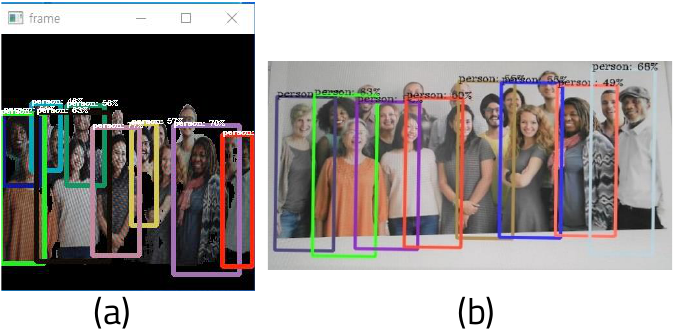
Figure 14. Result of detection of numerous people: ( a ) YOLO executed with ENet and ( b )